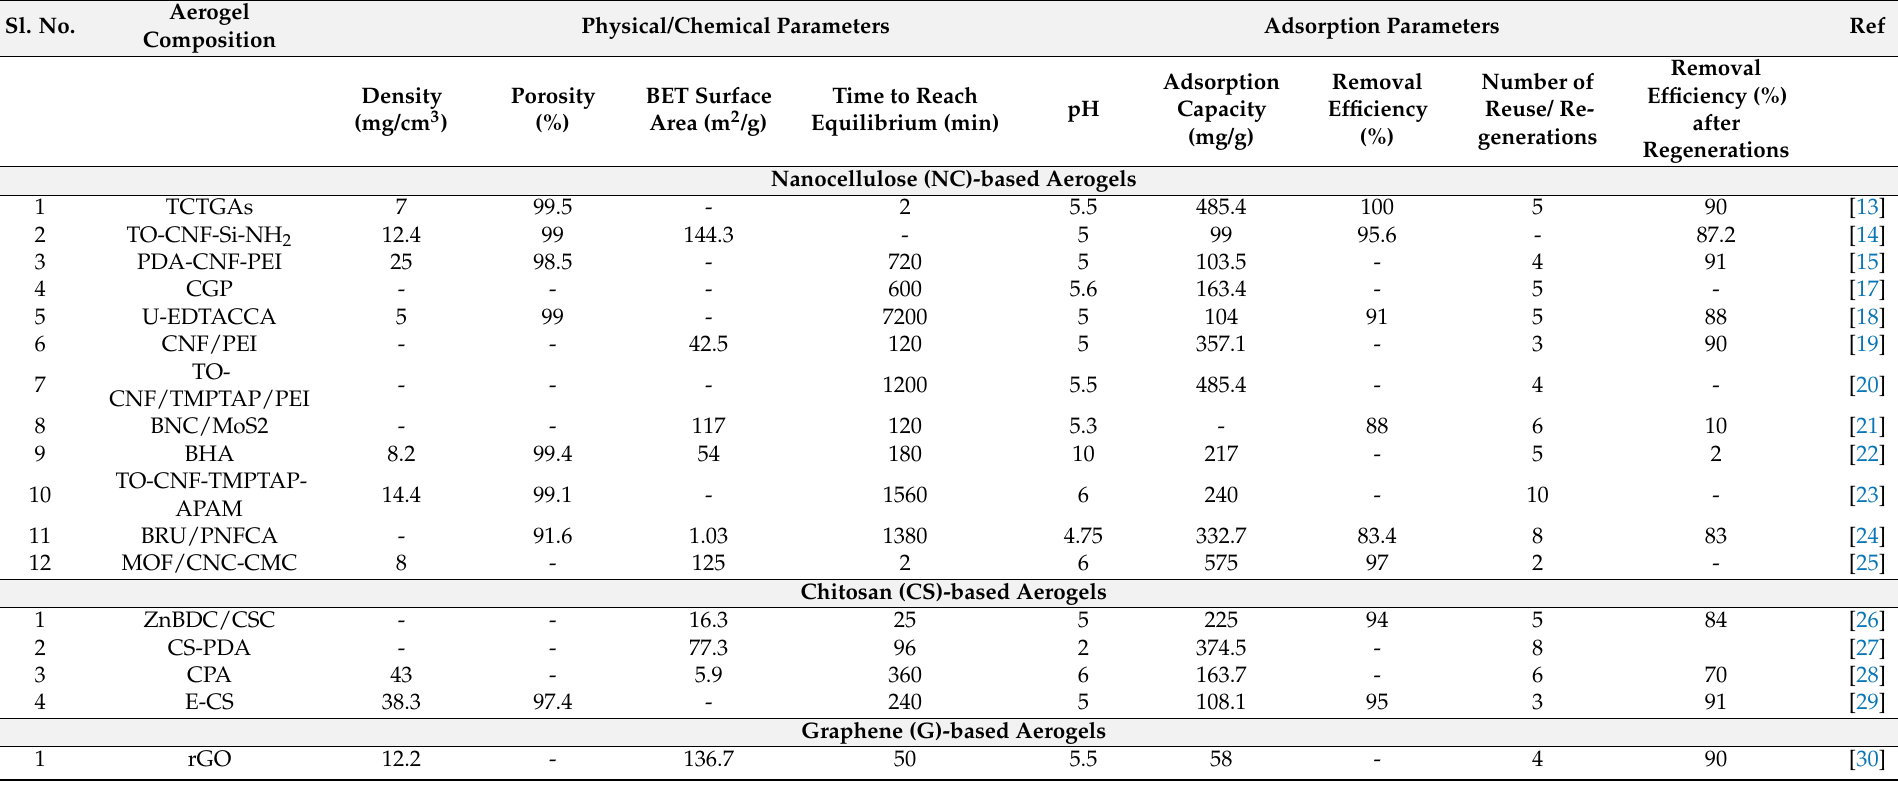
Table 1. Nanocellulose (NC)-, chitosan (CS)-, and graphene (G) oxide-based aerogels in ion removal: physical/chemical and adsorption parameters. (Adapted from Ref. [7] with permission from